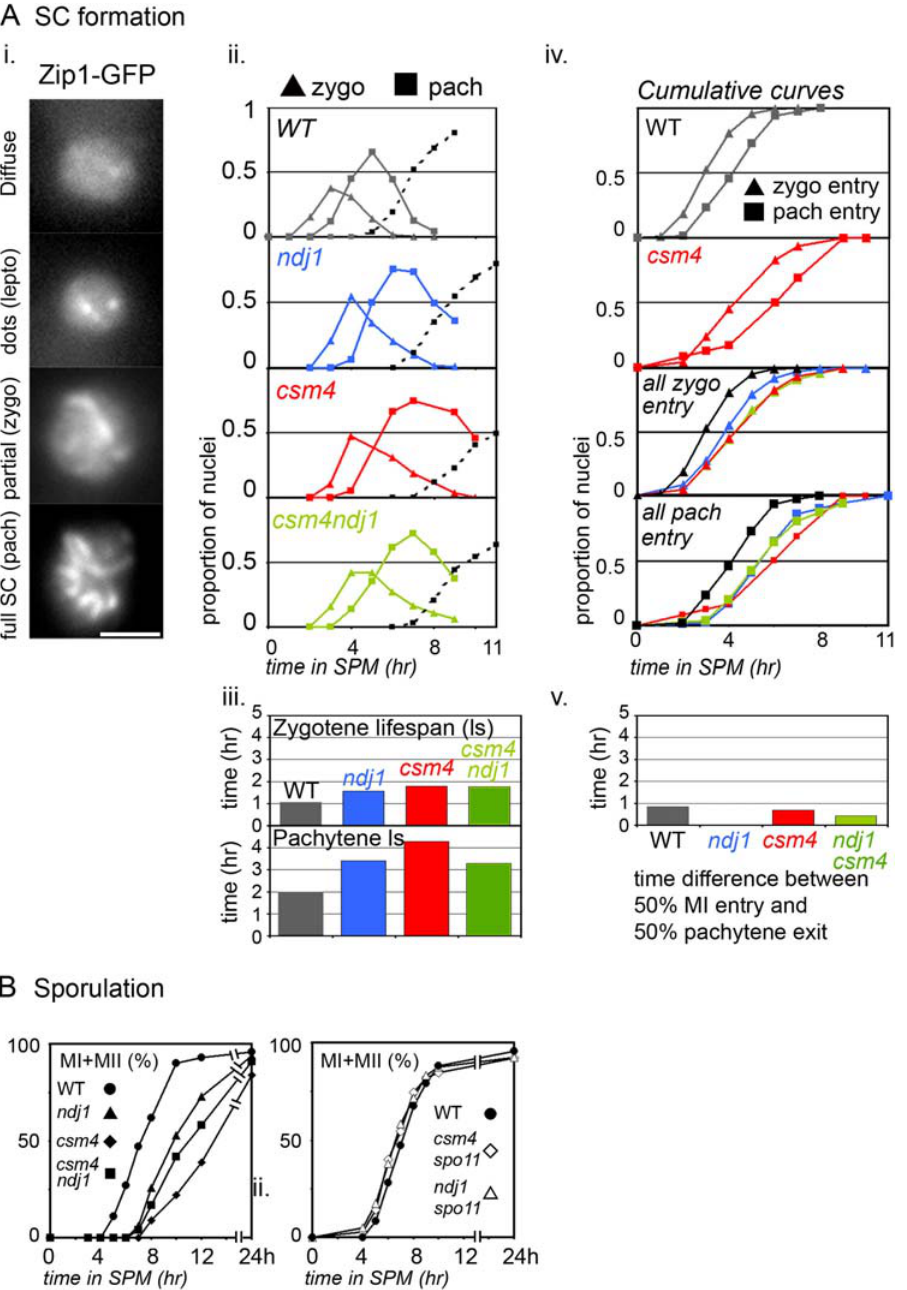
Figure 8. Synaptonemal complex formation and sporulation in ndj1 D / csm4 D mutants. A) Meiotic progression, as measured by the formation of synaptonemal complex (SC). Meiotic progression was monitored in strains where the SC was illuminated by Zip1-GFP(700) (for details, see [2,6]). i The various steps of SC formation are shown for a WT strain (NKY3834): after diffuse fluorescence, dots appear that correspond to formation of DSBs. Later, short lines correspond to the zygotene onset, whereas at the pachytene stage SC appears as linear, contiguous ribbons. ii For WT, ndj1 D , ndj1 D csm4 D , and csm4 D strains (NKY3834, NKY3837, NKY4003, and NKY4002, respectively), fixed nuclei where examined at hourly intervals and scored for zygotene (triangle symbol) or pachytene (square symbol) categories. The proportions of nuclei within one or the other categories are plotted as a function of time in SPM. Completion of MI (MI + MII) for each time course is indicated by a dotted line curve. iii zygotene and pachytene lifespan as deduced from the cumulative curve analysis for WT and ndj1 D , and csm4 D mutants. iv Cumulative curve analysis of zygotene and pachytene progression. The upper two panels indicate zygotene and pachytene for WT (top) and csm4 D (bottom). The lower two panels show the onset of zygotene (top) and pachytene (bottom) for all strains. Color code is the same as in ii. v For WT, ndj1 D , ndj1 D csm4 D , and csm4 D strains, differences between the time when 50% of the nuclei have progressed through MI and the time when 50% have exited pachytene. B) Meiotic progression, as measured by completion of MI divisions in WT (NKY3834), and in ndj1 D and csm4 D mutants without (full symbols, upper panel; strains NKY3837 and NKY4002, respectively) and with the spo11-Y135F mutation (empty symbols, lower panel; strains NKY3907 and NKY3908, respectively). All scale bars represent 2 m m.